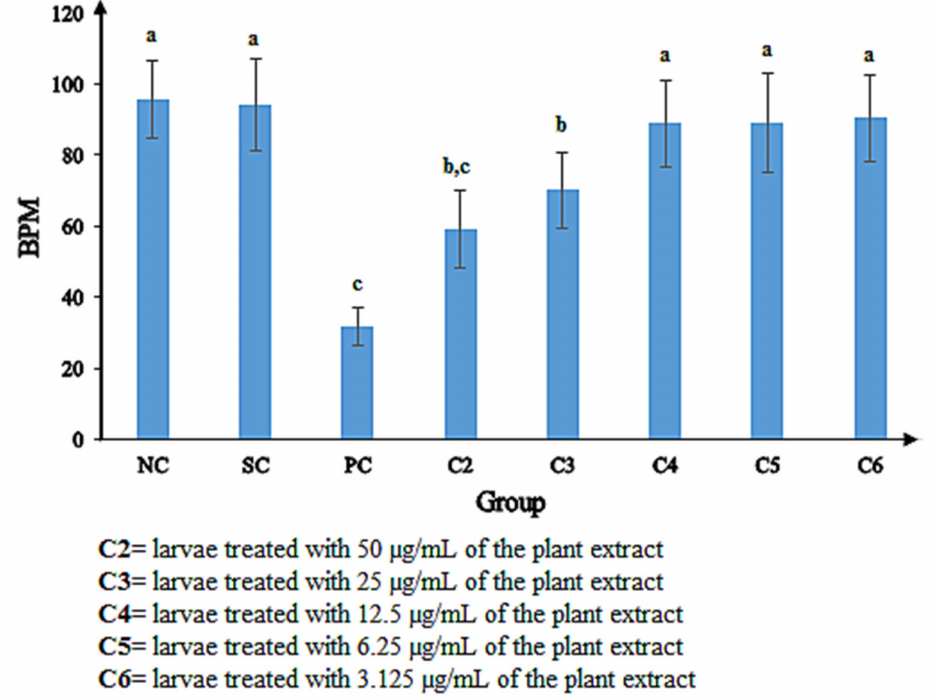
Figure 5. Heartbeat per minute (BPM) of zebrafish embryo/larvae exposed to different concentrations of methanol extracts along with the negative, solvent, and positive control. C2–C6 = treatment concentrations, NC = Negative control; SC = Solvent control; PC = Positive control. Different letters (a,b,c) indicate significant differences ( p < 0.05) among